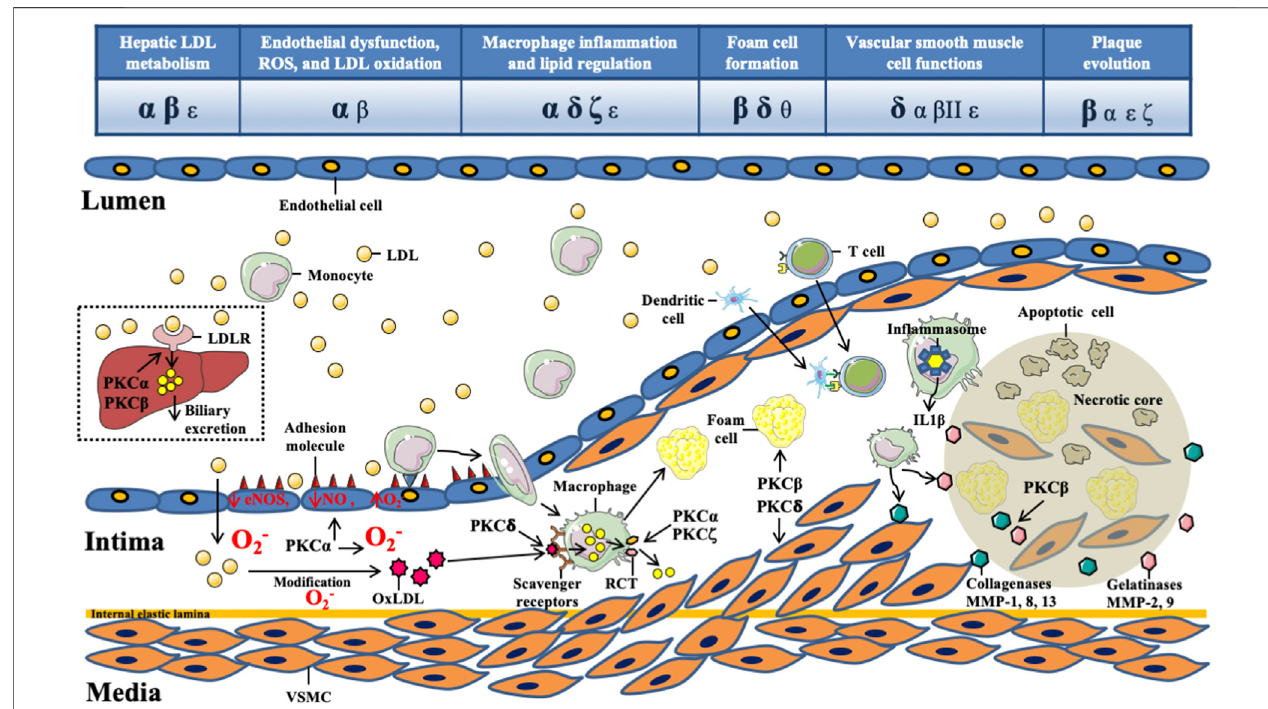
FIGURE 1 | The role of protein kinase C isoforms in the initiation and progression of atherosclerosis. The pathophysiology of atherosclerosis begins with the retention of circulating low-density lipoproteins (LDL) in the intima. Excess levels of circulating LDL are cleared via hepatic LDL receptor, which is regulated by protein kinaseC α (PKC α )andPKC β .TheintimalLDLsarepronetooxidativemodi fi cationbyenvironmentaloxidizingenzymestobecomeoxidizedLDLs(oxLDLs),whichactivate endothelial cells (ECs) to express adhesion molecules. The major PKC isoforms involved in this step are PKC α and PKC β . PKC α , PKC δ , and PKC ζ regulate the expression of ATP-binding cassette transporter A1, which plays a key role in macrophage cholesterol ef fl ux. PKC β and PKC δ regulate foam cell formation via manipulating scavenger receptor-mediated uptake of oxLDLs by macrophages. Vascular smooth muscle cells (VSMCs) proliferate and migrate from the media to the intima in response to environmental stimuli. PKC δ plays a critical role in regulating VSMC function during atherosclerosis. Both innate and adaptive immune systems are involved in the atherosclerotic process. Apoptosis of VSMCs and secretion of matrix metalloproteinases (MMPs) from macrophages are critical for plaque complexity. PKC δ is the principal isoform regulating VSMC apoptosis. Finally, PKC β II had been proposed to regulate MMP secretion in ECs during atherosclerosis.